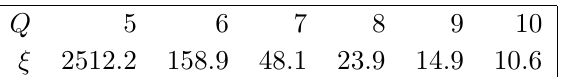
Table 1 . The 2d Potts model correlation length on the square lattice at the (cid:12)rst-order phase transition for Q = 5 - 10, computed from [24], eq.